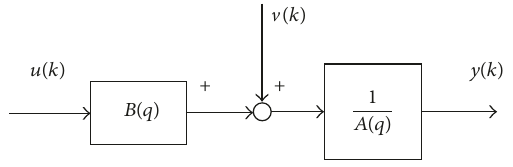
Figure 4: ARX model in block diagram form.